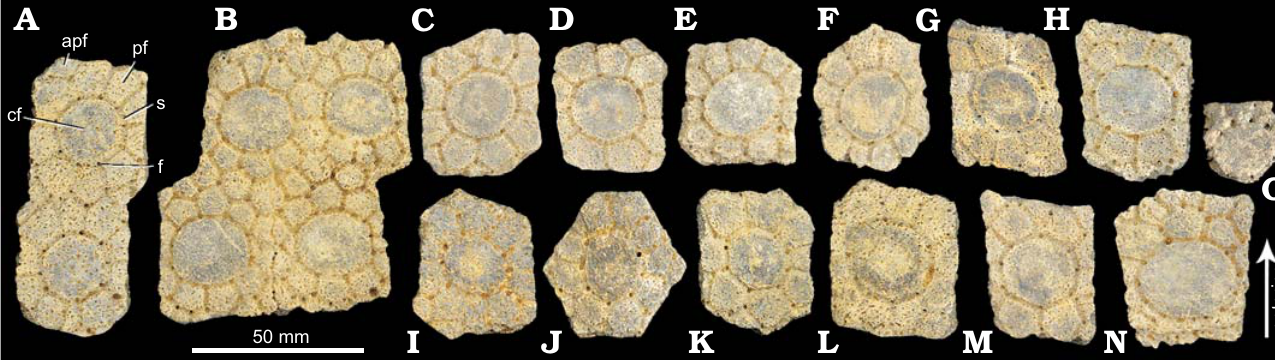
Fig. 3. Osteoderms of old specimens (MACN A 11137, syntype) of glyptodont Palaehoplophorus meridionalis Ameghino, 1904 from Río Fénix and Lago Blanco, Patagonia, Serravallian–Tortonian, middle–late Miocene. Osteoderms from posterior region ( A – N ) and caudal ring ( O ). Abbreviations: apf, acces- sory periferal figure; cf, central figure; f, foramina; s, sulci; pf, periferal